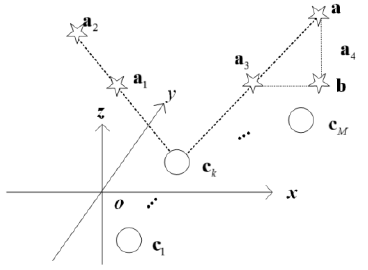
Figure 3. The coplanar and non-coplanar source geometries ( N = 4).